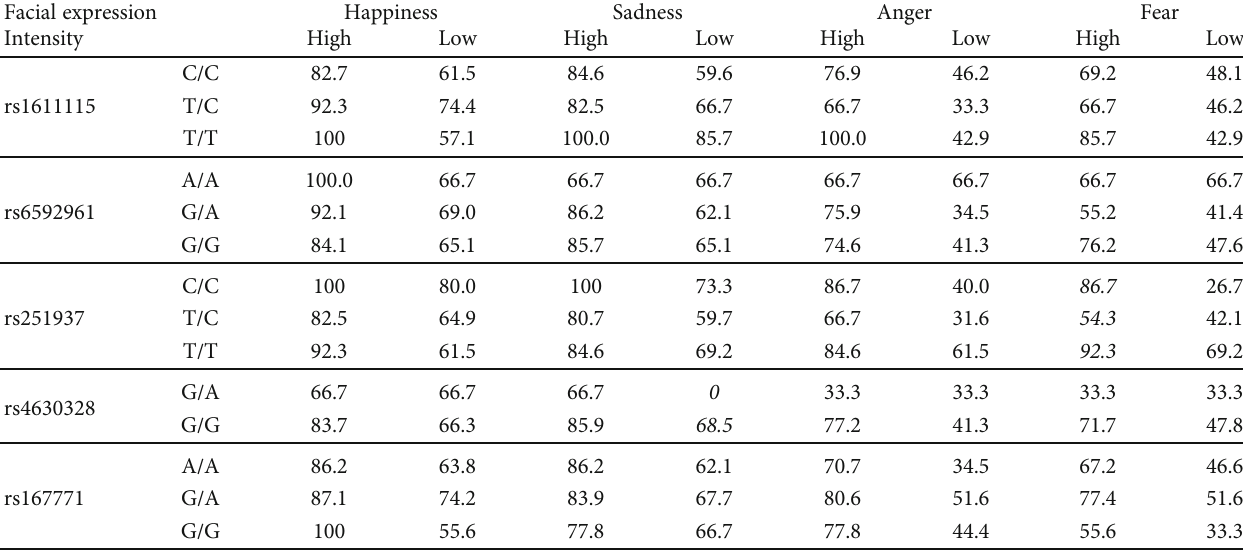
Table 4: Association between SNPs and accuracy in facial emotion recognition in children with ASD. Facial expression